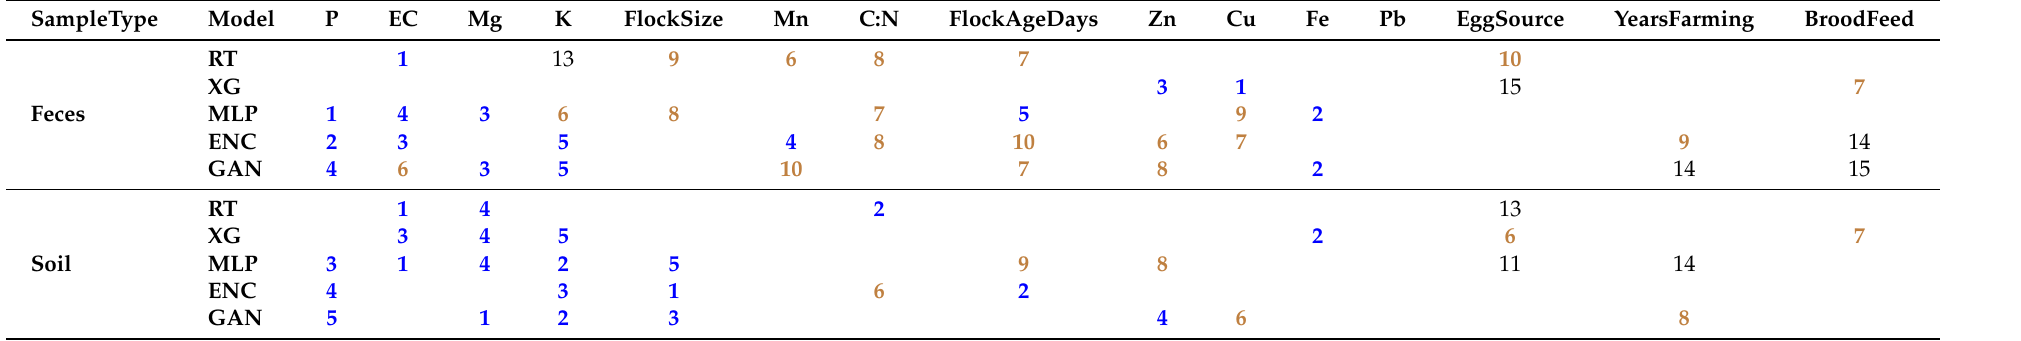
Table 4. The influential variables and their rank in their respective algorithm for the prediction of Campylobacter multidrug resistance (C_MDR). Please see Table A1 for variable descriptions. The top five ranks are shown in blue and the top ten in brown . Overall, the top five most influential variables for C_MDR in feces are P, EC, Zn, Cu, and Mn, while the top five for soil are EC, K, FlockSize, Mg, and